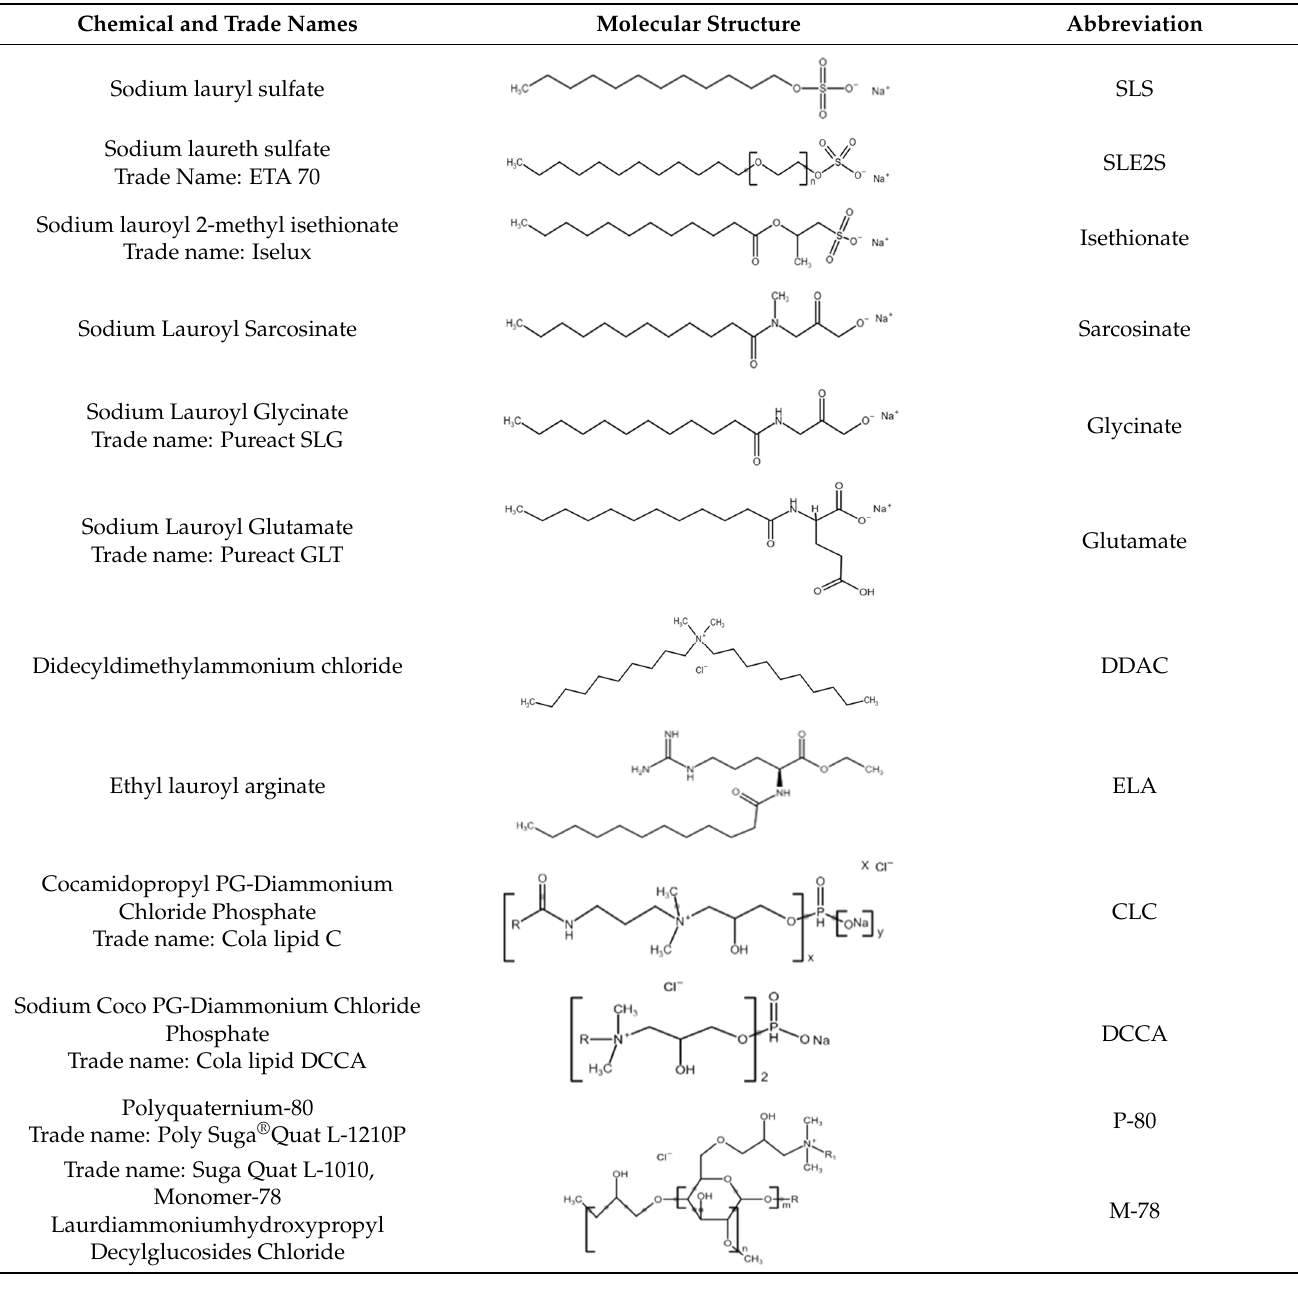
Table 1. Chemical and trade names, molecular structure, and abbreviation of the diverse cationic and anionic molecules studied in this